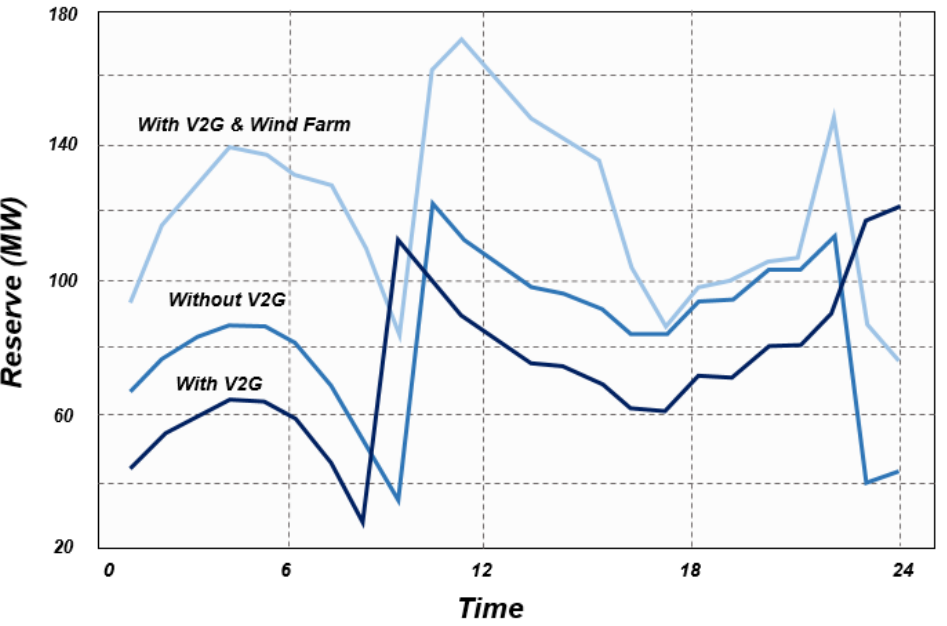
Figure 6. Spinning reserve of generation system for each hour during different scenarios (redrawn from [25]).